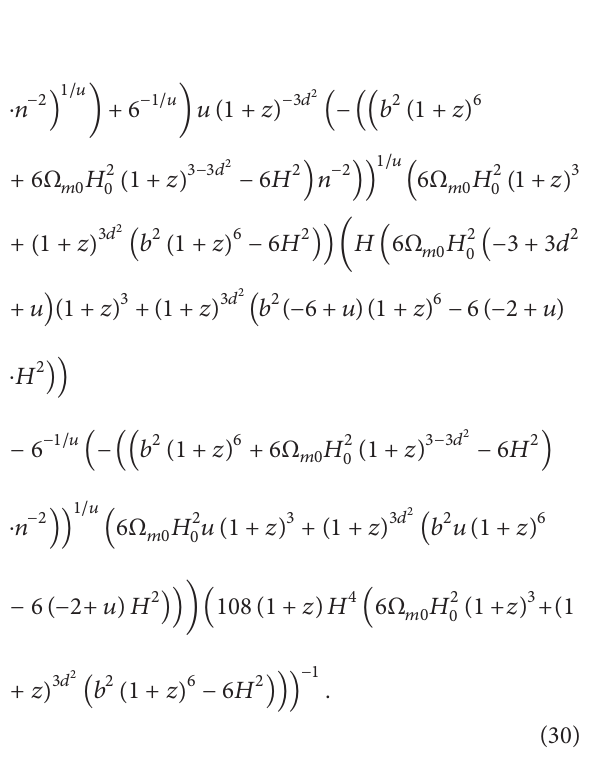
, 𝜔 󸀠 ) = (−1, 0) , in all cases of 𝑑 2 for 𝑢 = 1 (right (𝜔 𝜗 𝜗